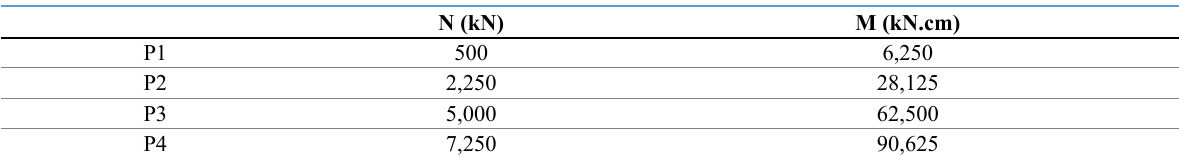
Table 2. Values of forces acting on the